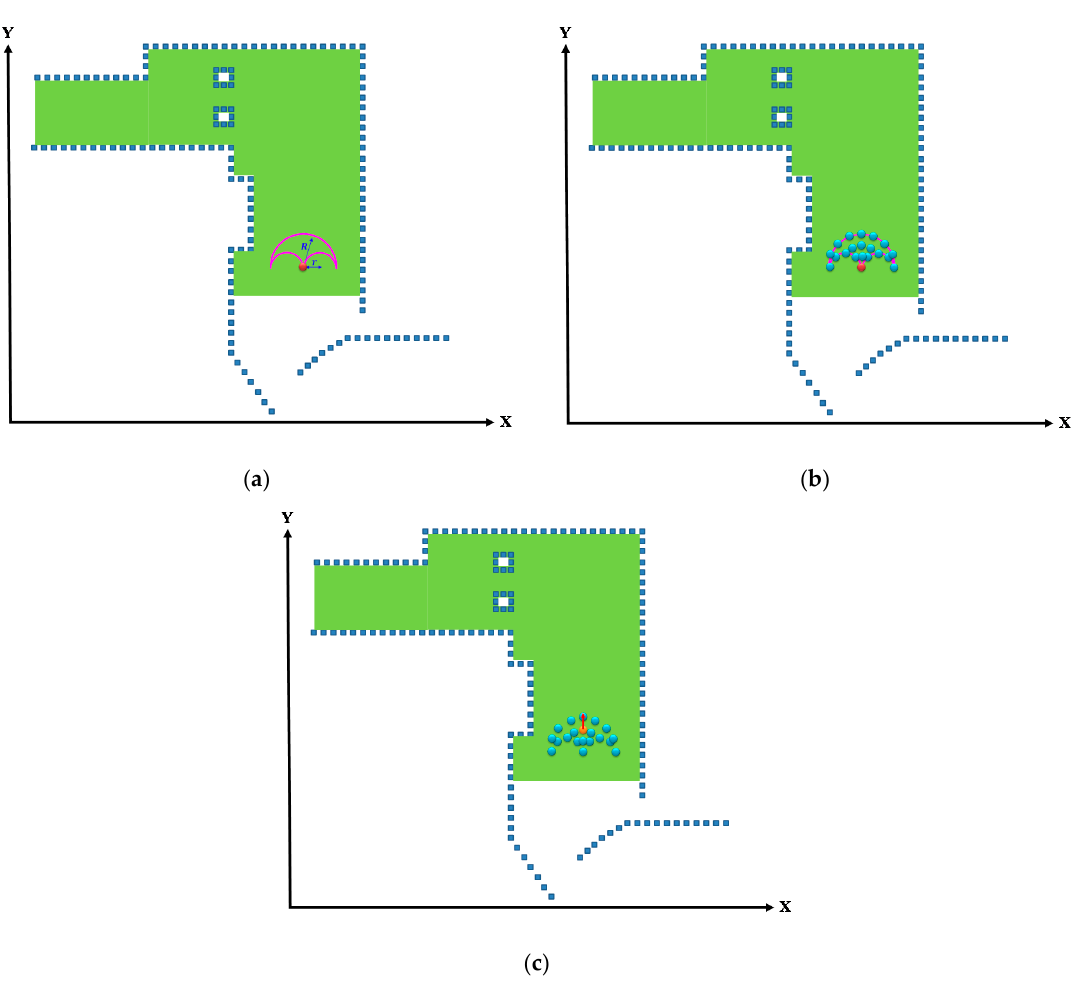
Figure 11. Locating the vehicle through DMR-based localization. ( a ) Search range of the DMR. ( b ) Possible current locations. ( c ) Estimated location and direction.